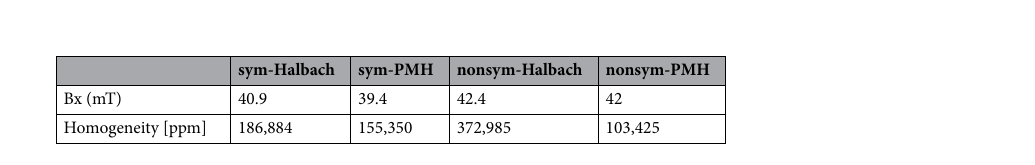
Table 3. Arbitrary shaped magnets: Halbach and PMH